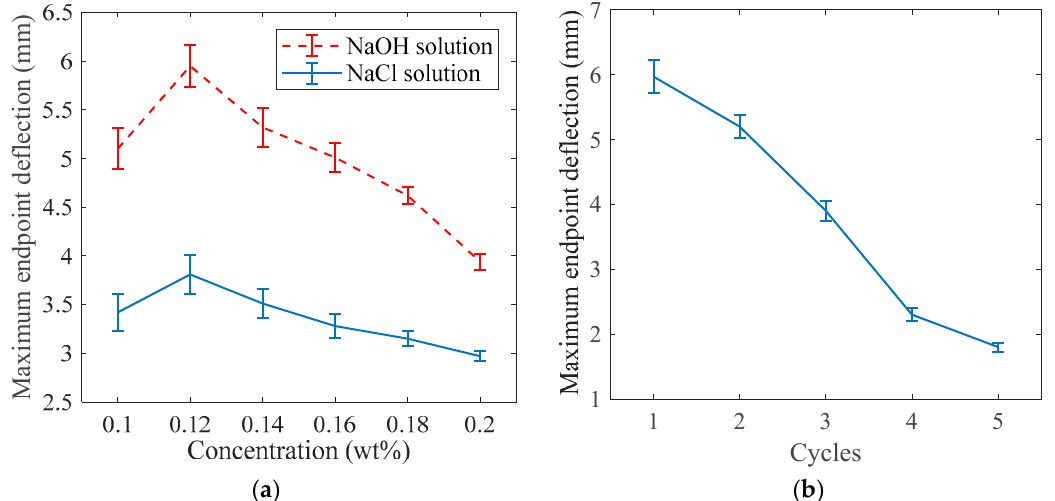
Figure 4. ( a ) Response of the actuators with the same pattern and dimensions to different electrolyte solutions. ( b ) Maximum endpoint deflections of the actuators to 5 V input signal over different cycles. Error bars indicate the standard deviation of the maximum distance measured over the three trials. Table 1. The results of maximum endpoint deflection for the same pattern and different sizes of 3D- printed actuators.